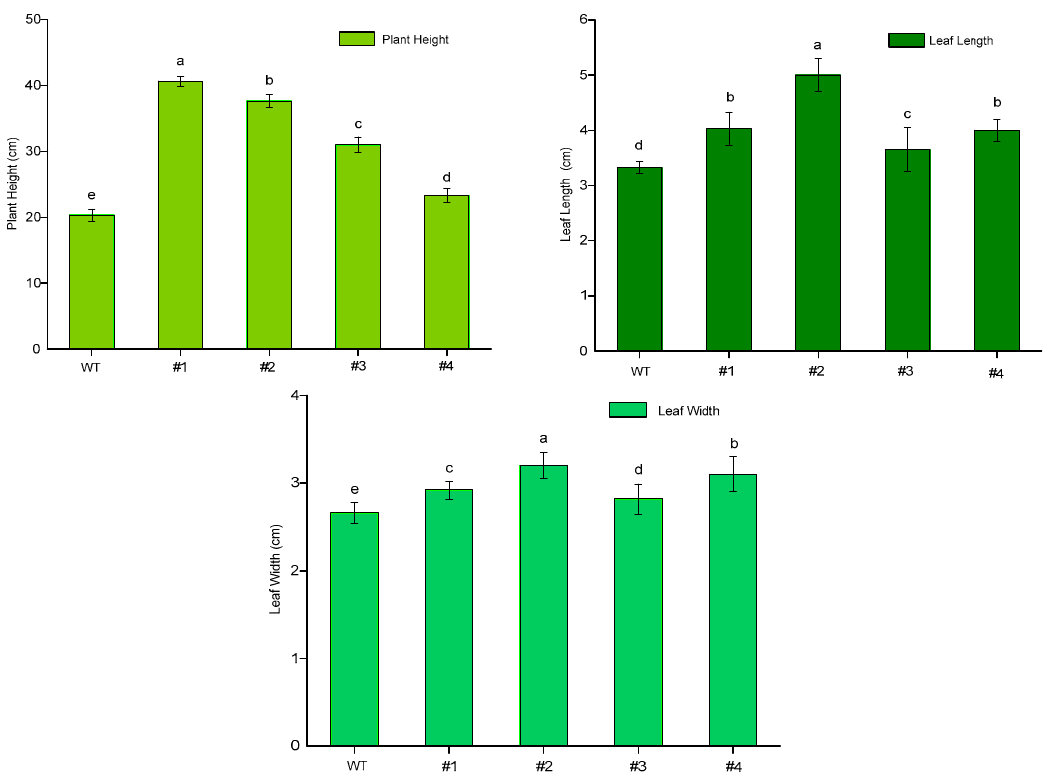
Figure 10. Growth potential (plant height, leaf length and leaf width in cm) of CmTFL1a transgenic chrysanthemum. Three biological replicates were used. Error bars represent ± SD. a, b, c, d, and e are statistically significant at p ≤ 0.05 by ANOVA on ranks test.